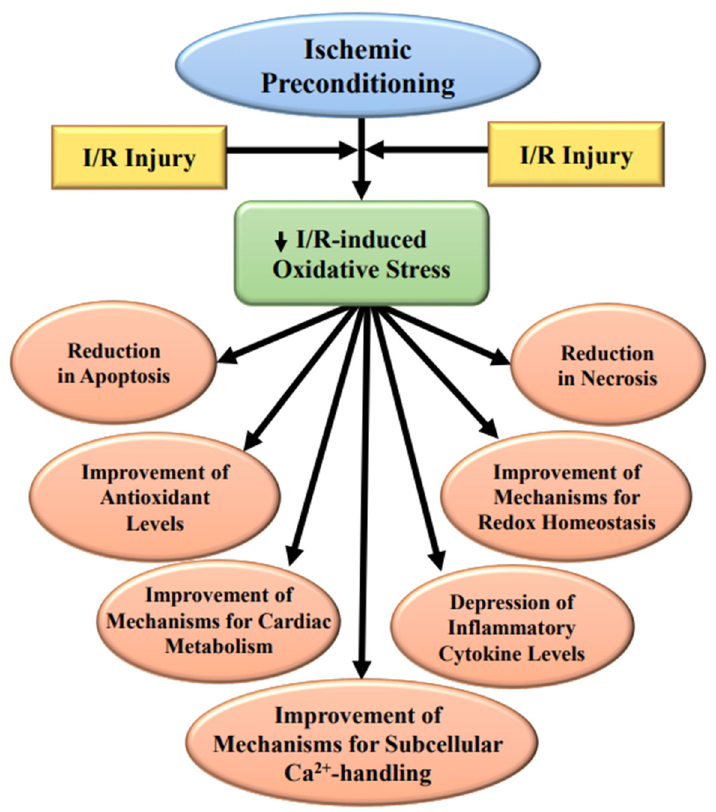
Figure 1. Alterations in some ischemia–reperfusion induced (I/R) parameters in hearts subjected to ischemic preconditioning.